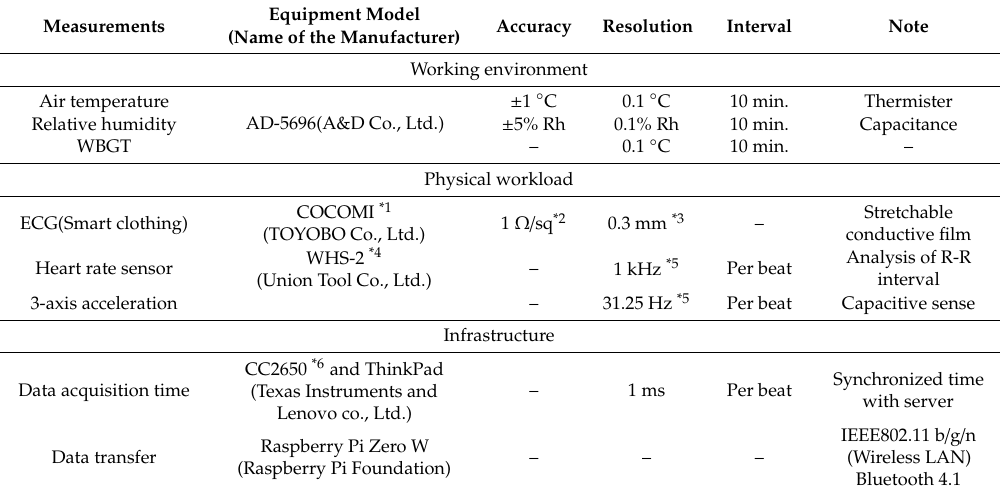
Table 1. List of measurement equipment used for measuring meteorology and